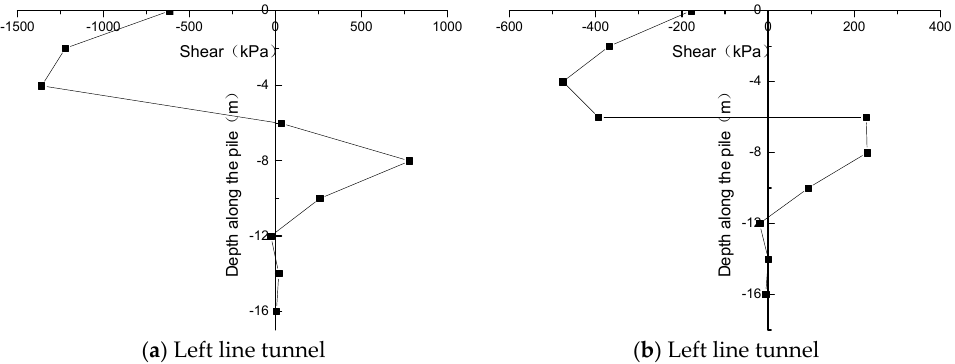
Figure 15. Shear curve of the fender post. ( a )Left line tunnel; ( b ) Left line